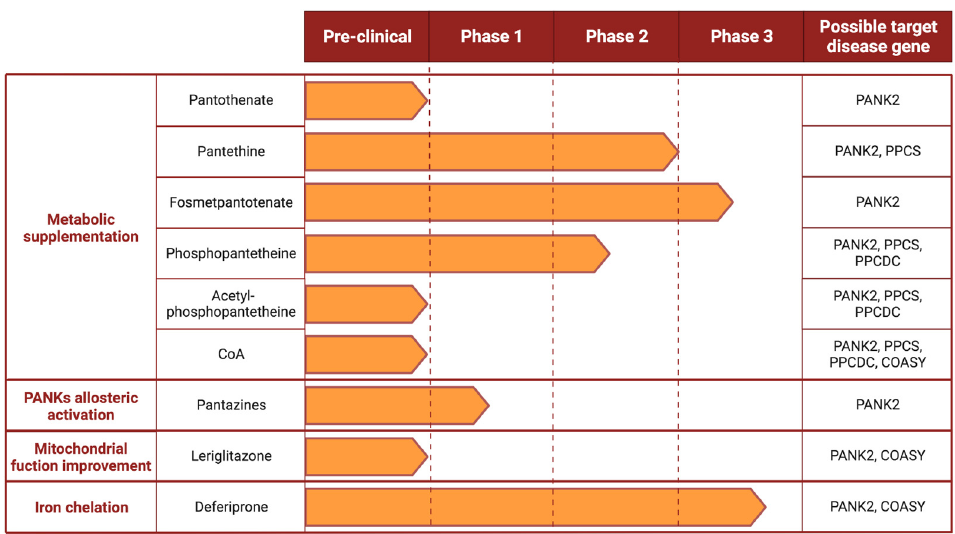
Figure 3. Proposed therapeutic strategies for inherited disorders of CoA biosynthesis and their current stage of development.